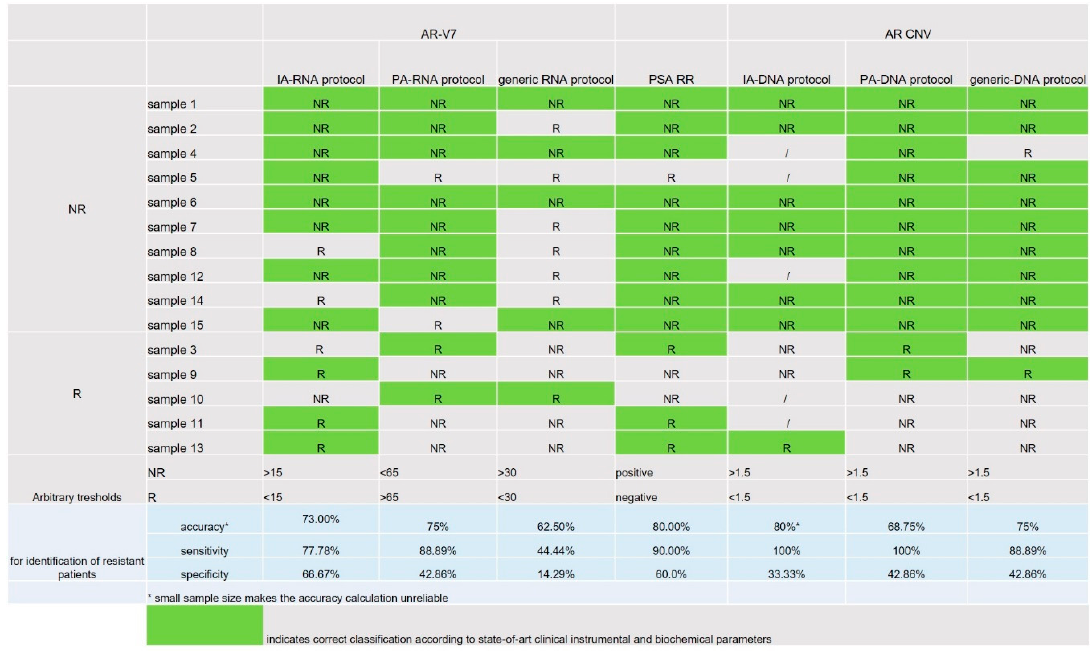
Figure 6. Prediction for a sample to be R or NR based on each single parameter and arbitrary thresholds. In green, the correct correlation with the predicted status according to clinical, instrumental and biochemical parameters.